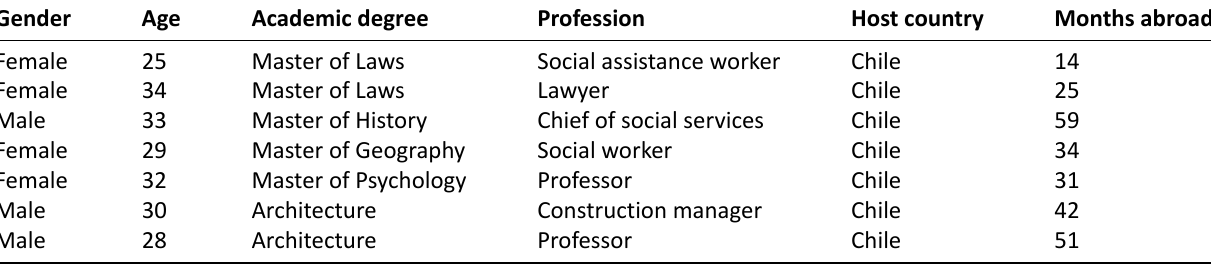
Table 2. Profiles of the participants in the discussion